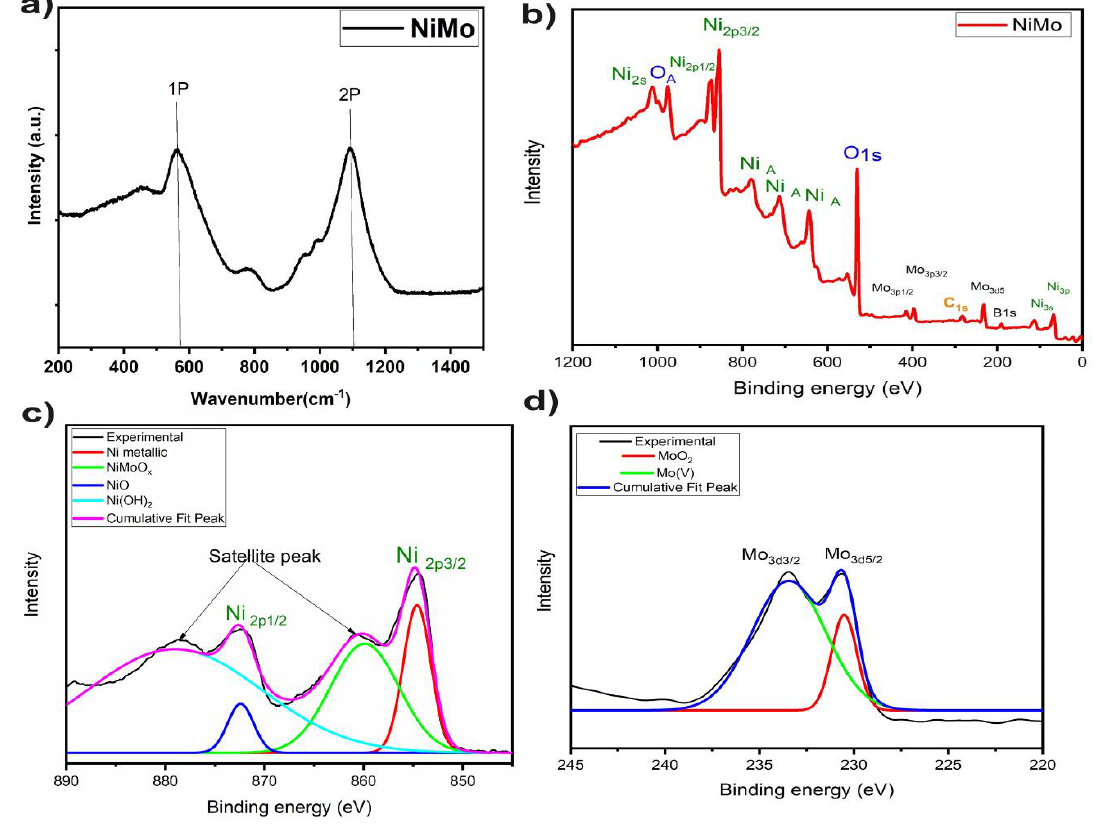
Figure 3. ( a ) Raman spectrum of Ni 0.9 Mo 0.1 nanosheets, ( b ) X-ray photoelectron spectroscopy (XPS) spectrum of Ni 0.9 Mo 0.1 nanosheets, ( c ) XPS peak fitting of Nickel peaks ( d ) XPS peak fitting of Mo peaks.